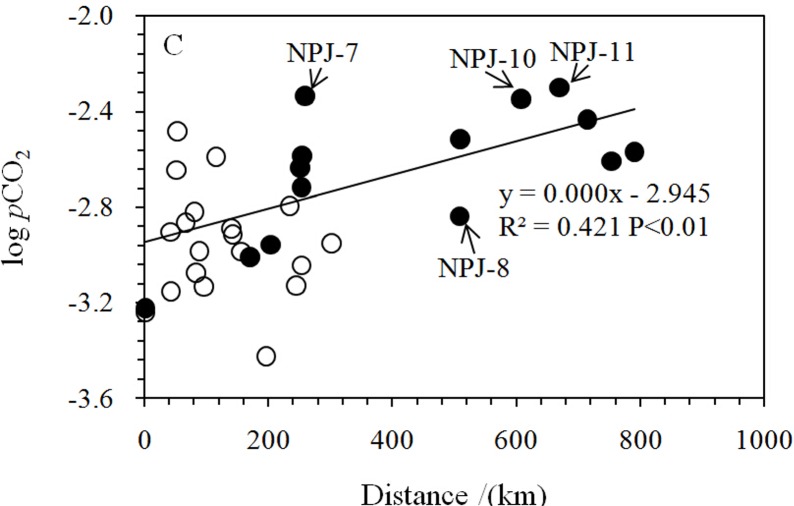
Correlation between DIC content and δ13CDIC.The trend line applies to data from the BPJ.